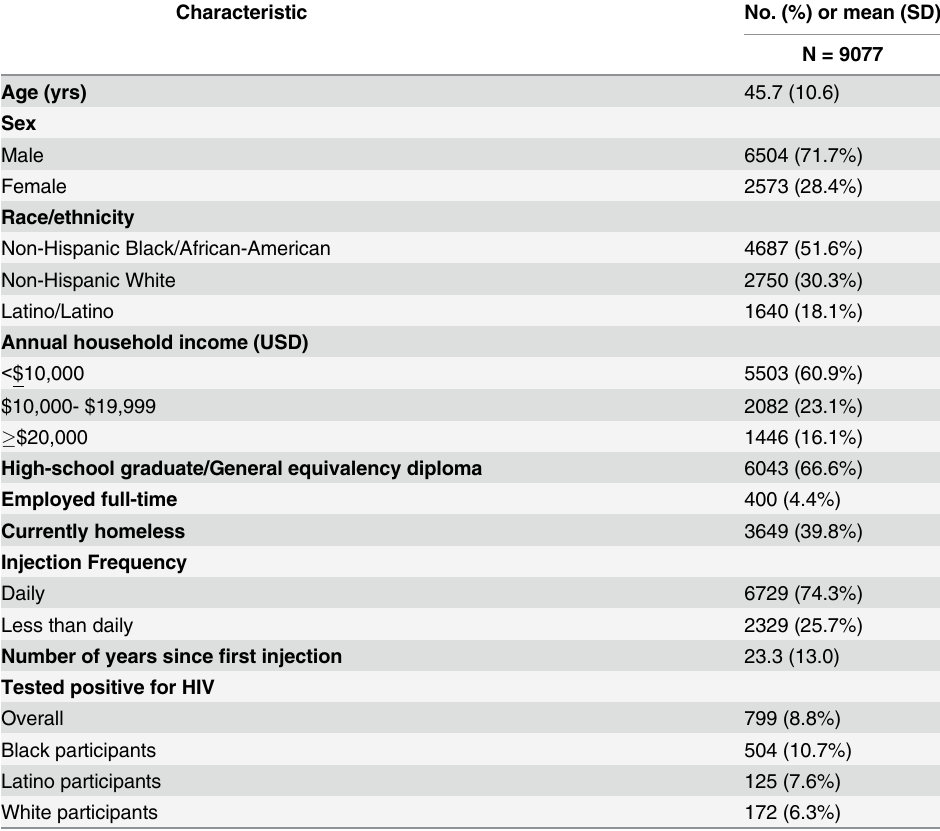
Table 3. Characteristics of the sample of people who inject drugs (PWID), drawn from the 2009 Cen- ters for Disease Control and Prevention ’ s National HIV Behavior Surveillance.